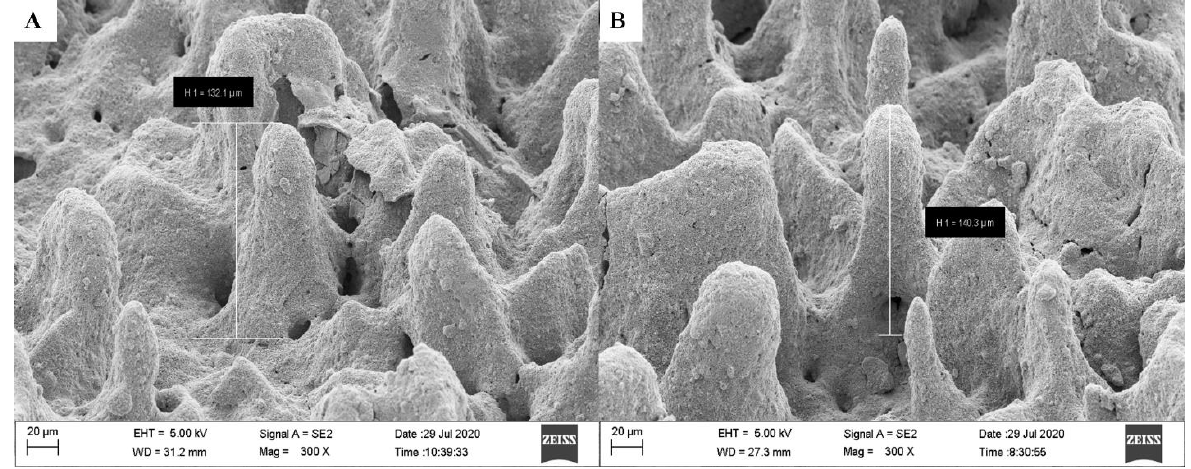
Figure 15. SEM micrographs of TiO 2 surface morphology coated on the Pyrex glass substrate.